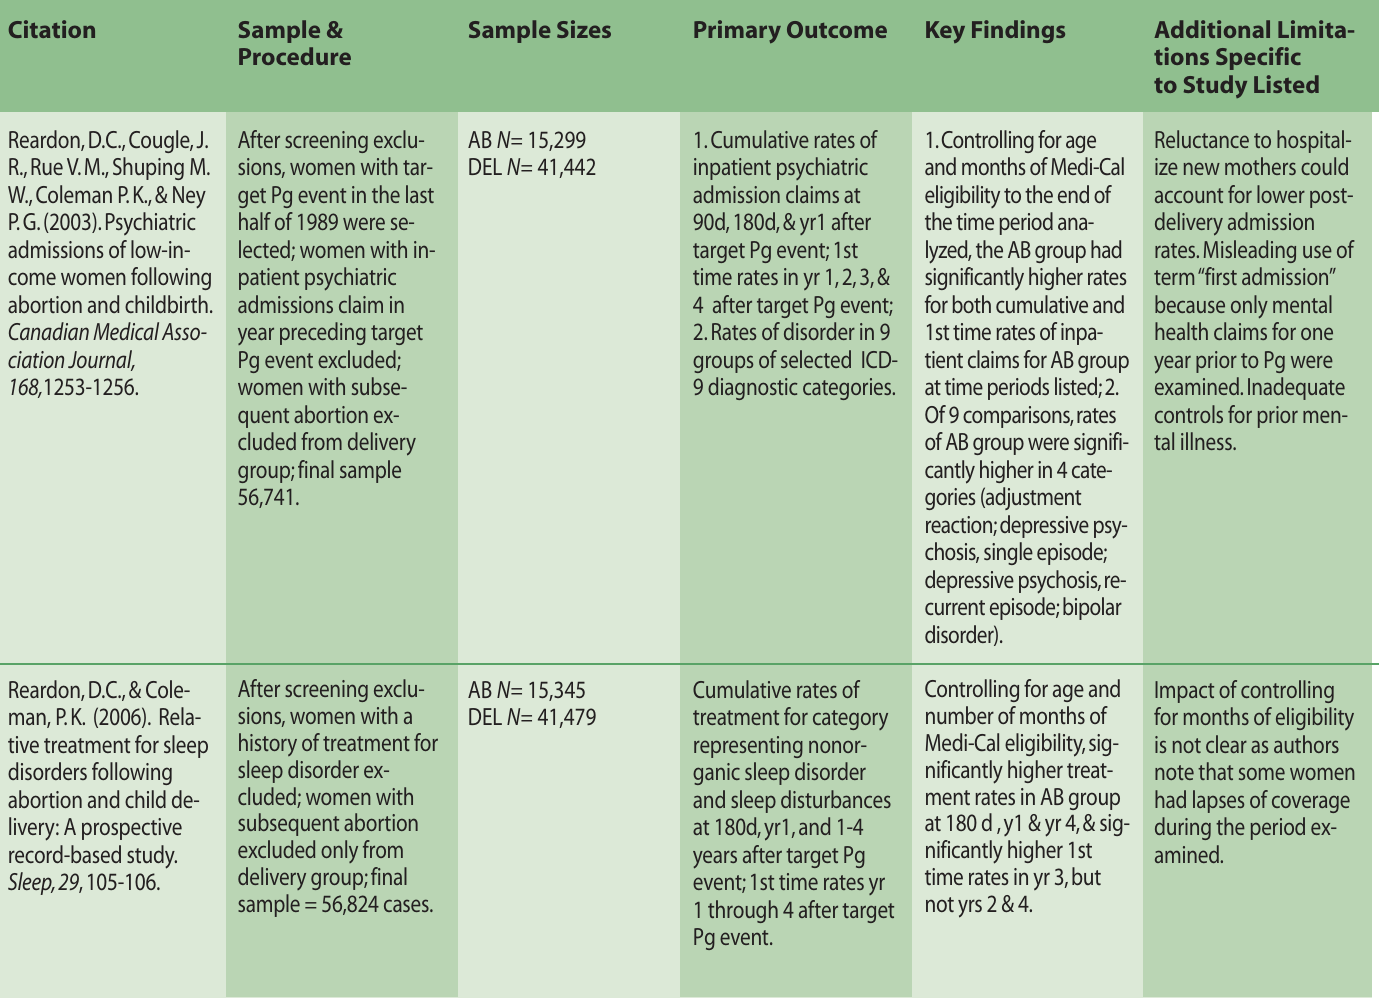
Table 1: Medical Records–Abortion vs.Comparison